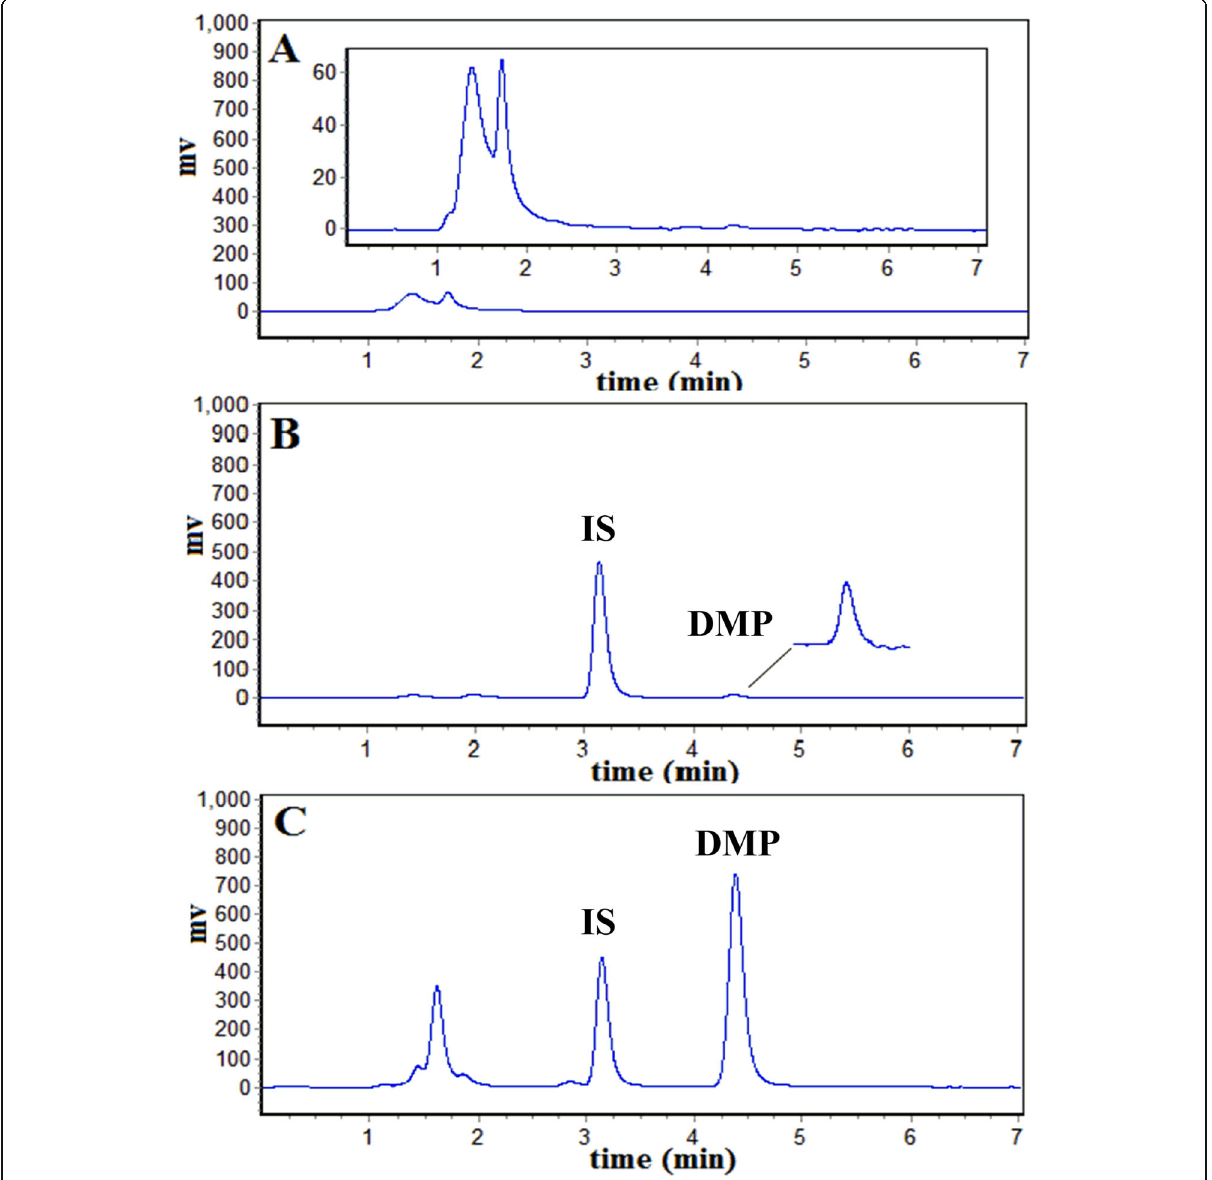
Fig. 2 The representative chromatograms for DMP and curcumin (IS) in rat plasma: a blank plasma; b blank plasma sample spiked with DMP (10 ng/mL) and curcumin as internal standard (IS); c plasma sample obtained at 20 min after oral administration of 1.605 g/kg MR extract (DMP 1963.54 ± 902.27 ng/mL; IS 10 μ